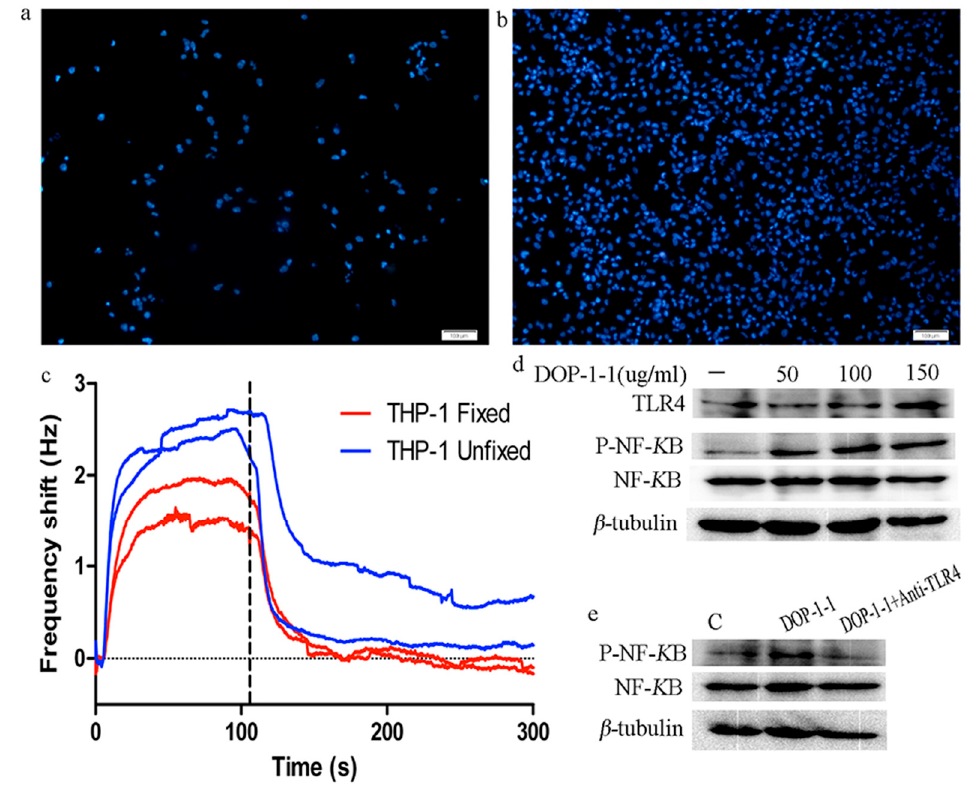
Figure 5. Interactions between DOP-1-1 and protein receptors on THP-1 cells. ( a , b ) Evaluation of Cell coverage on sensor surface test: QCM measurements by staining the nuclei of THP-1 cells with Hoechst33342 and visualized under a fluorescent microscope. ( c ) Sensograms and binding data for each DOP-1-1 and THP-1 cells. ( d ) Effects of DOP-1-1 on TLR4 and NF- κ B protein and β -tubulin. ( e ) Effects of DOP-1-1 on NF- κ B protein by blocking TLR4 and β -tubulin.